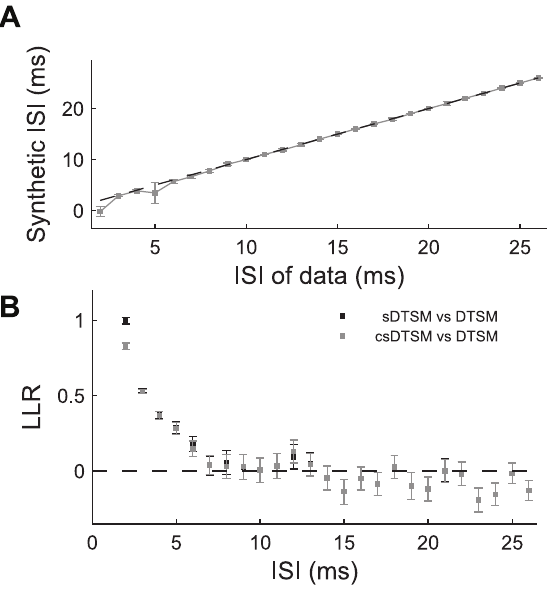
Figure 8. Non-linear compression. A: Non-linear mapping between input ISI (x axis) and best-match synthetic ISI (y axis), determined from peaks in likelihood. B: Effects of non-linear compression on estimates of log-likelihood ratios. Black points show LLR between synthetic (‘synth mod 1’) and data-based doublet models, as in 7D, gray points show LLR between synthetic model modified by non-linear compression (‘synth mod 2’) and data-based doublet models.